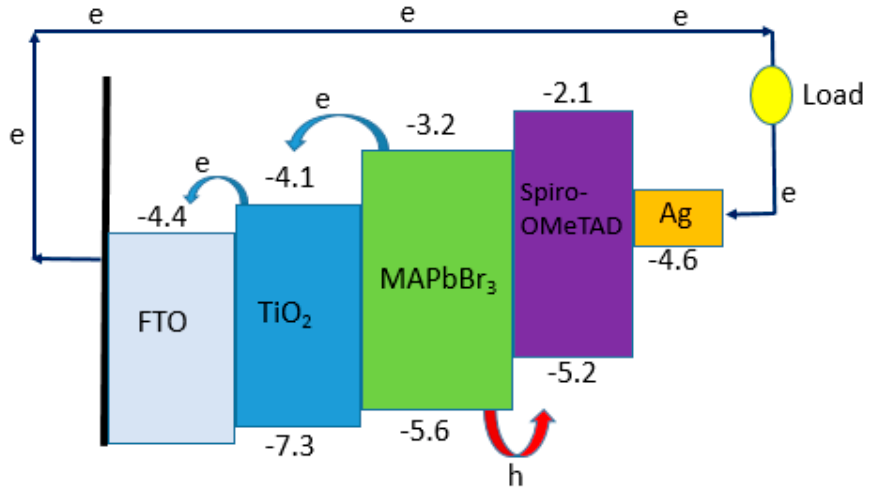
Table 3. Solar cell parameters of MAPbBr 3 and Ag-irradiated MAPbBr 3.